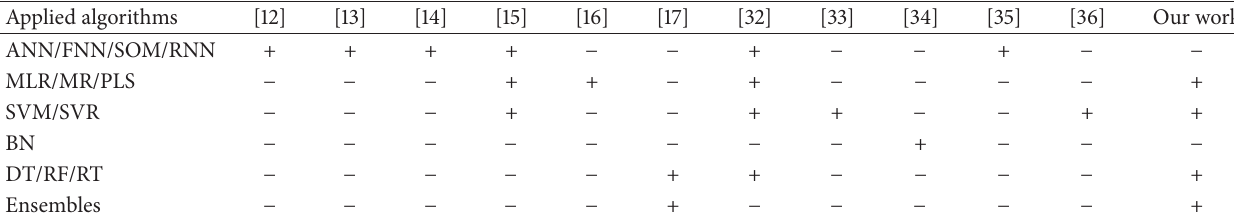
Table 1: ML models for heat demand prediction in the